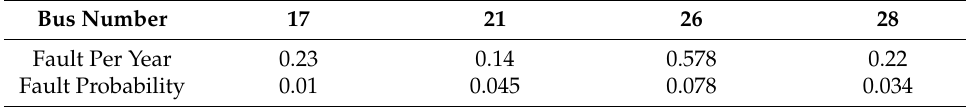
Table 5. Fault rate of high risk selected bus.